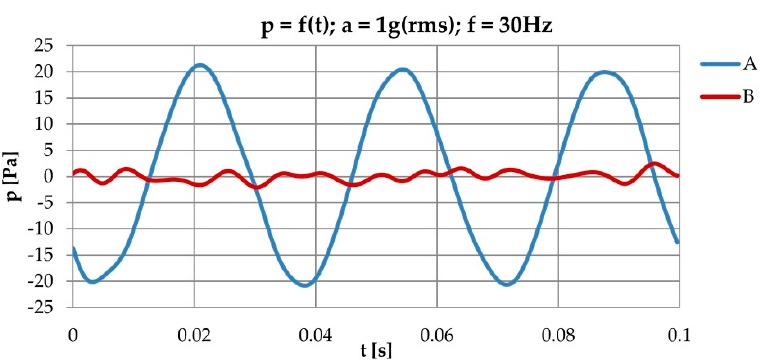
Figure 13. Dependency chart of the influence of dynamic acceleration on the output signal from the converter in the form of instantaneous values for a = 1g and f = 30 Hz, A- without correction, and B- with proposed correction.